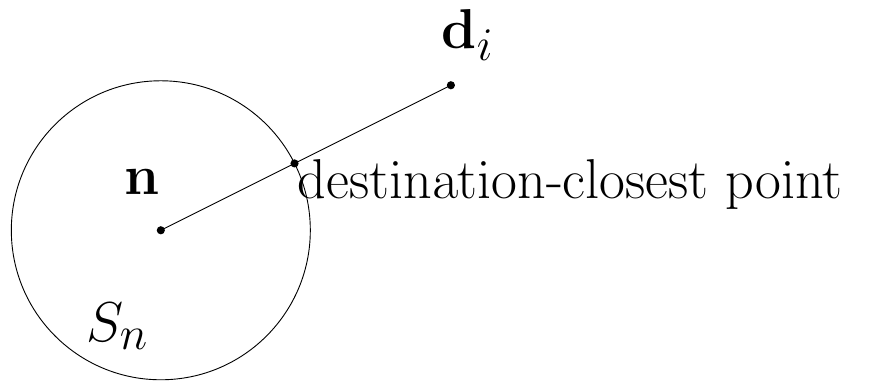
Figure 2. S n meets L ( n , d i ) at one point, termed the destination-closest